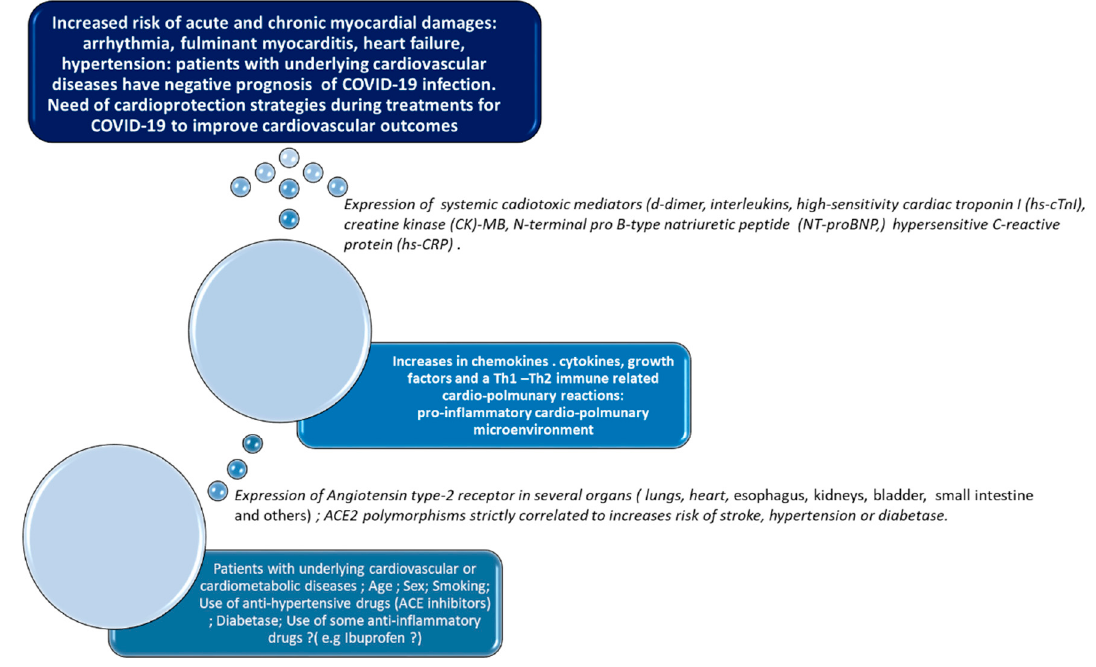
Figure 2. A representative scheme of the general cardio-metabolic risk factors, prognostic factors involved in coronavirus disease-2019 (COVID-19), and cardiovascular outcomes.